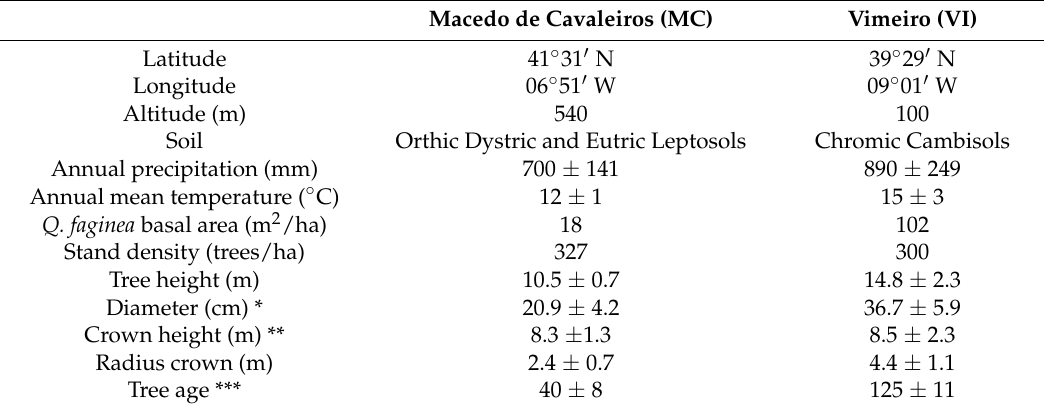
Table 1. Description of the sampled Quercus faginea trees by each site. Mean of ten trees and standard deviation.